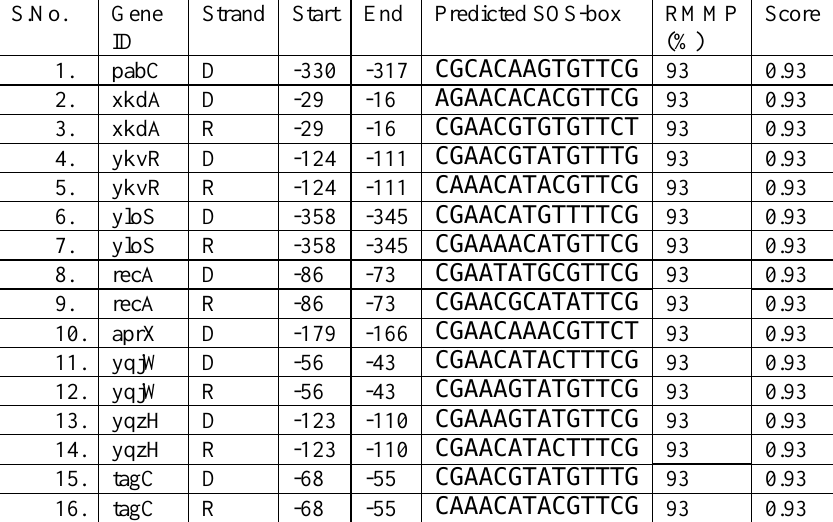
Supplementary Table 14 (S14): Genome wide detection of known B. subtilis SOS-box (CGAACRNRYGTTCG) in the upstream sequences (-400 bp) of B. subtilis through direct pattern matching method alone. Only 16 genes were